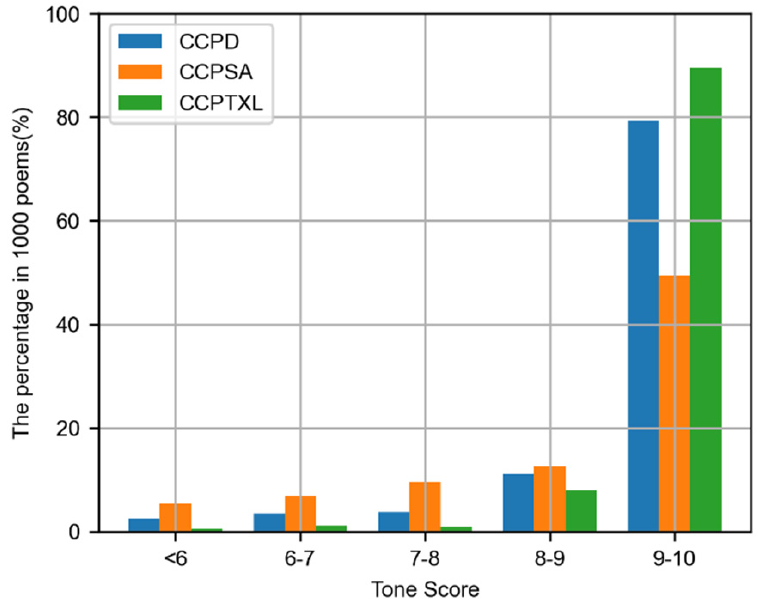
Figure 5. The distribution of tone score of poem datasets.